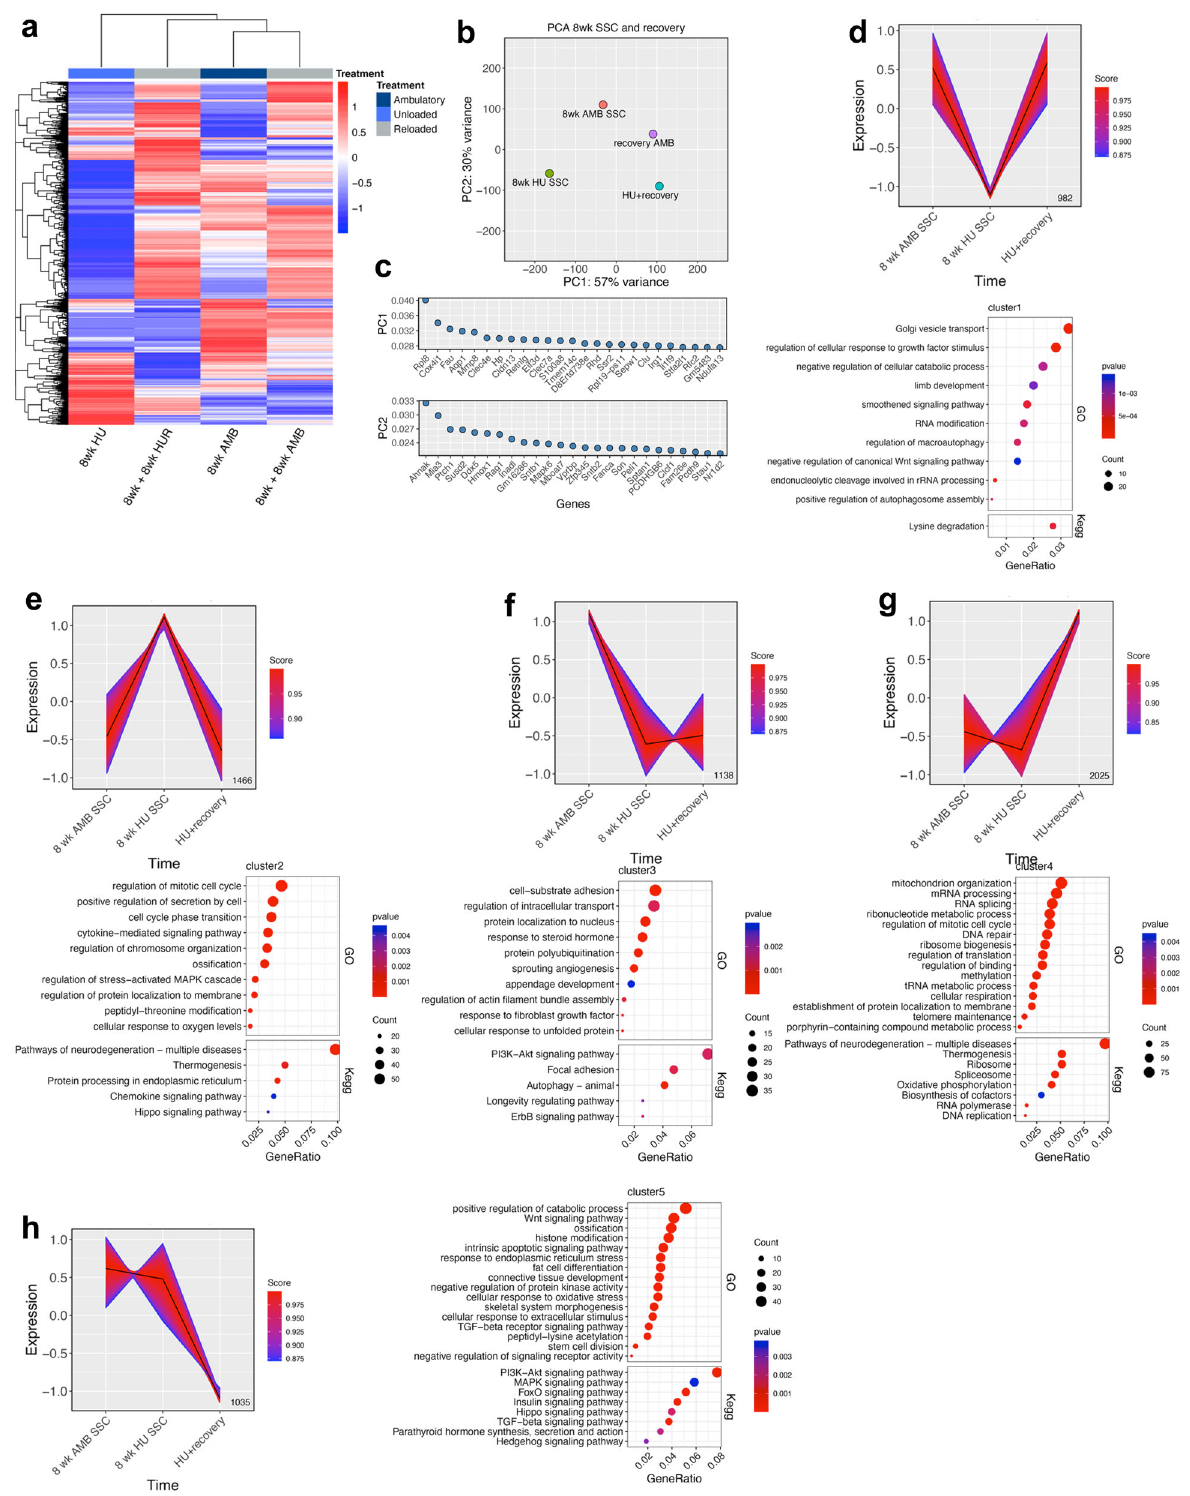
Fig. 6 HU and HUR result in temporal and dynamic changes in the SSC transcriptome. a Heat map of the top 1000 DEGs from RNA-seq analysis of LEPR + SSCs from AMB, HU, and HUR mice. Colors correspond to per-gene Z -score computed across each row. b , c PCA analysis ( b ) of data from a and genes contributing to PC1 and PC2 ( c ). d – h Gene expression patterns identi fi ed by K-means clustering of RNA-seq data from a and corresponding GO terms (upper dot plot) and KEGG pathways (lower dot plot) based on p -value and gene count identi fi ed by gene enrichment from each